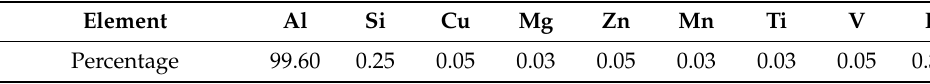
Table 1. Composition of industrial pure 1060 aluminum (wt.%).